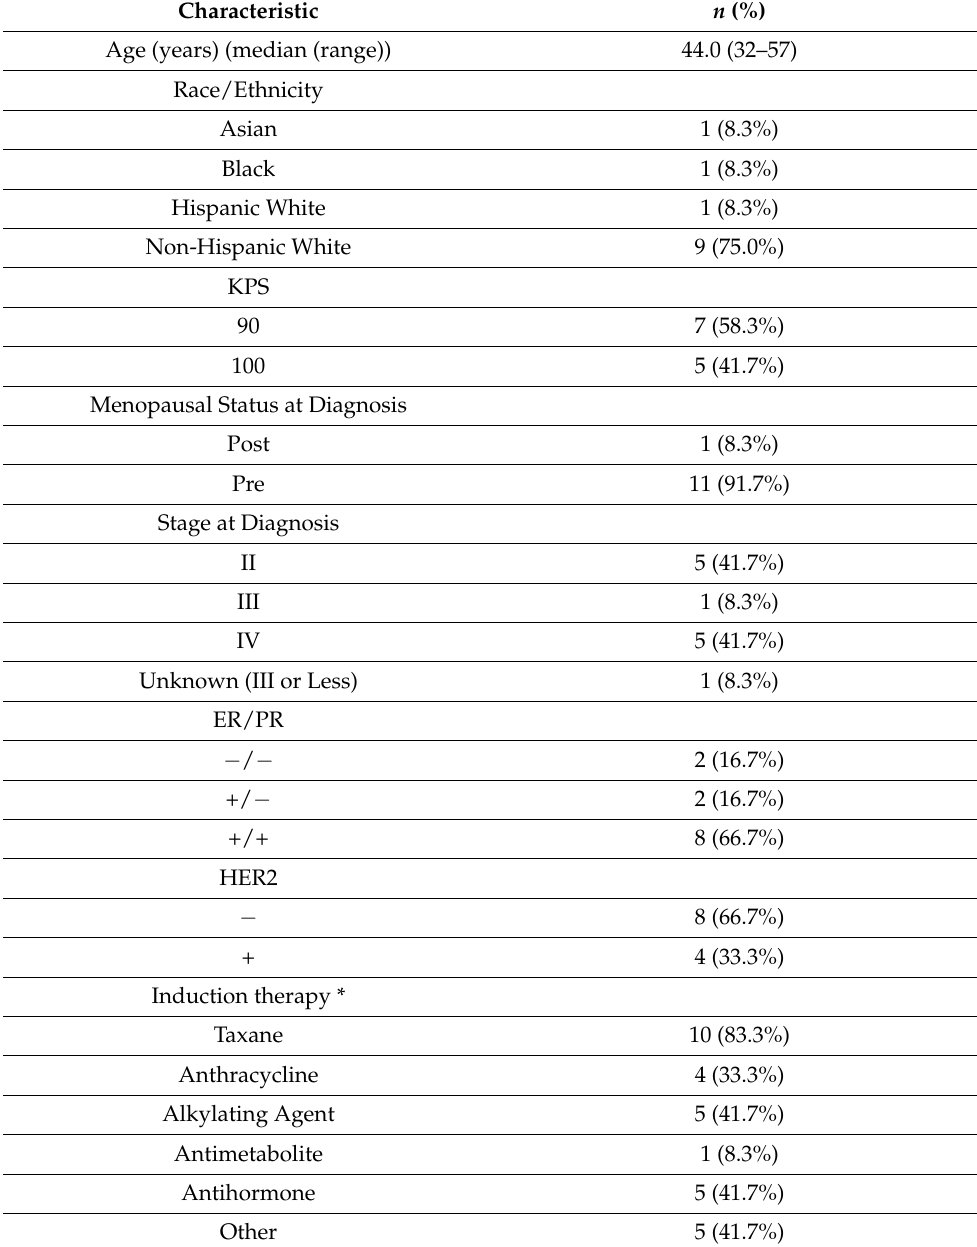
Table 1. Patient and treatment